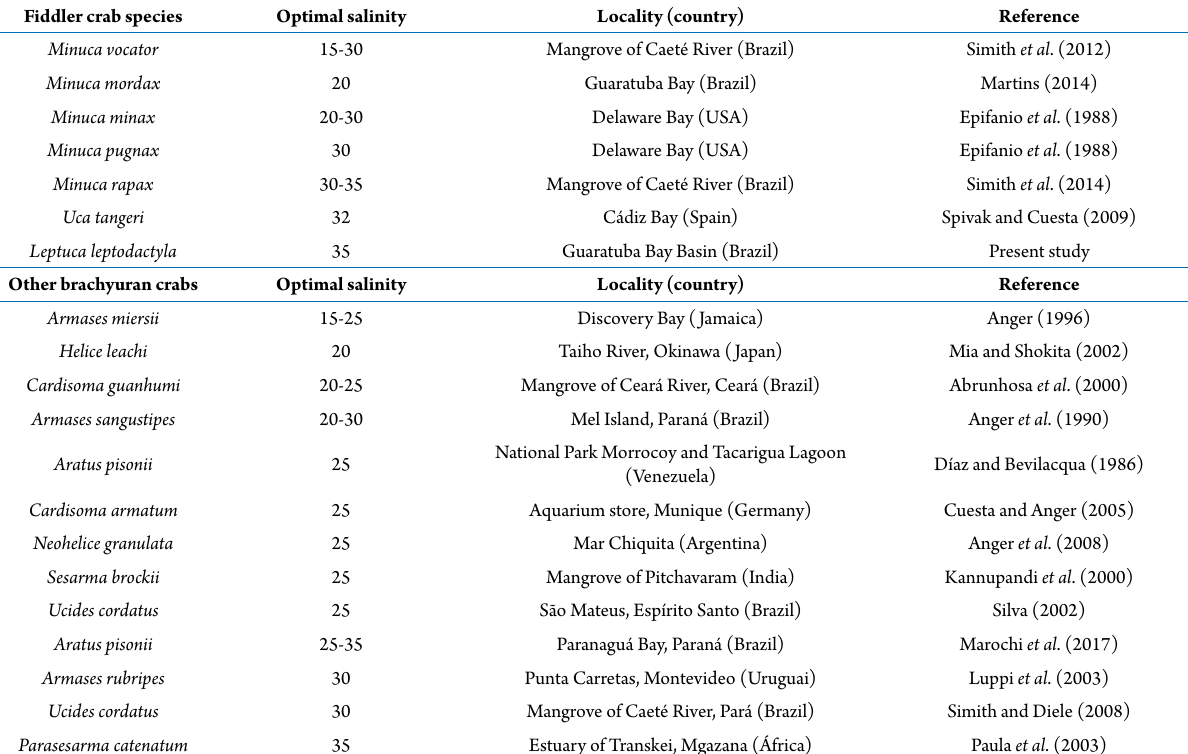
Table 4. Optimal salinity for larval development of the semi-terrestrial brachyuran crabs. Fiddler crab